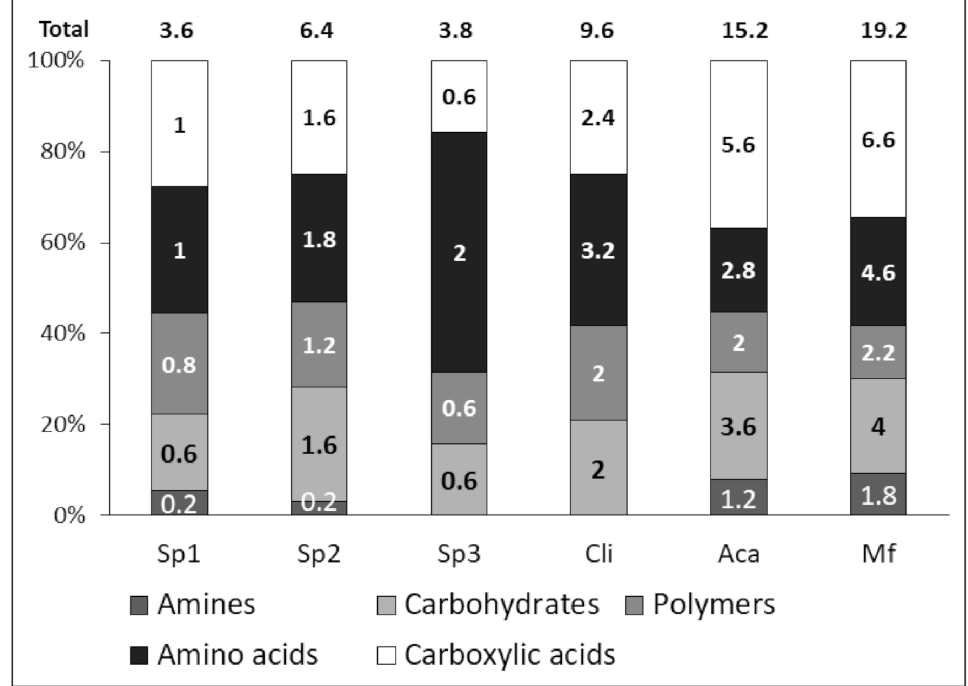
Figure 1. Percentage degradation of substrates according to biochemical categories for the various rehabilitated soils. Sp1, Sp2 and Sp3 are non-restored mining sites. Cli is a restored site with C. racemosa , Aca is a restored site with A. mangium , and Mf is a mixed fabaceous species. The value in each bar of the histograms is the average value of positive wells ( n = 5) for the different substrate categories. The value at the top of each histogram corresponds to the average value of positive substrates for each of the sites studied ( n =